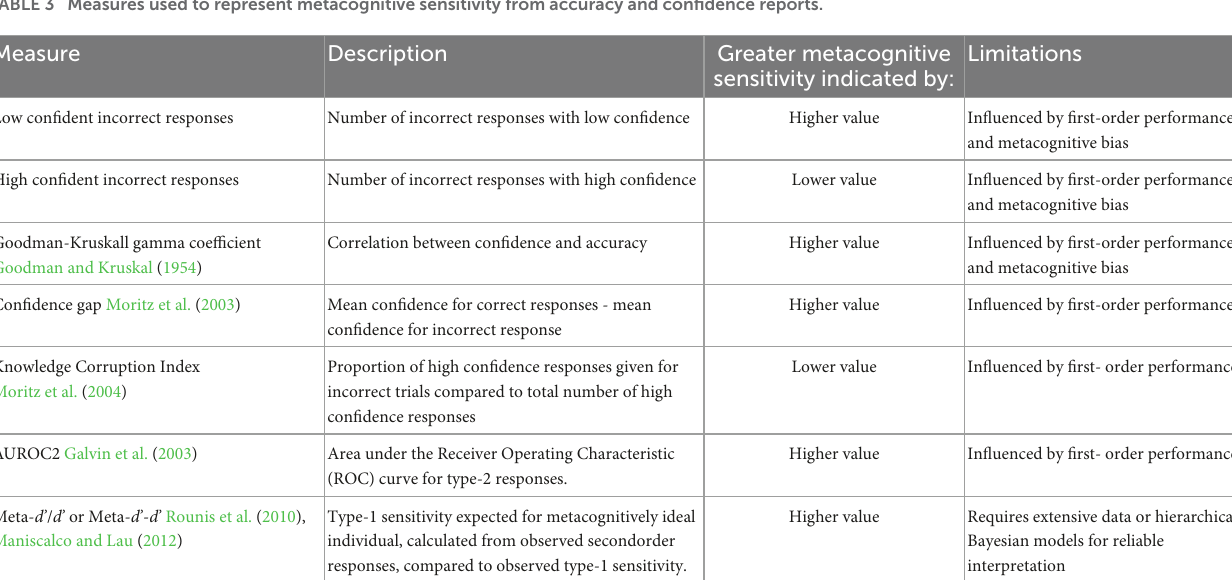
TABLE 3 Measures used to represent metacognitive sensitivity from accuracy and confidence